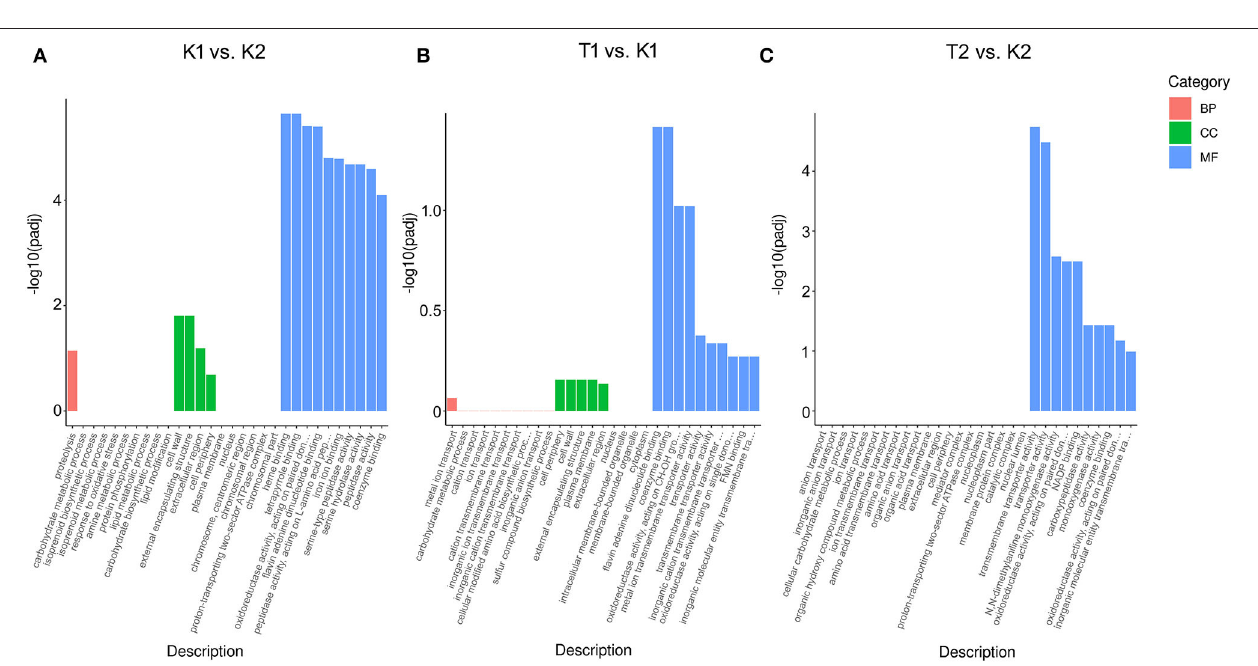
FIGURE 3 | Histogram of GO enrichment analysis of DEGs in compared groups of (A) K1 vs. K2, (B) T1 vs. K1 and (C) T2 vs. K2. The three parts of the GO enrichment result in each compared group exhibited the top 10 terms each, with red columns indicating the biological process, green columns denoting the cellular component, and blue columns indicating the molecular function. Y-axis (–log10padj) indicates the significance difference of GO term enrichment.